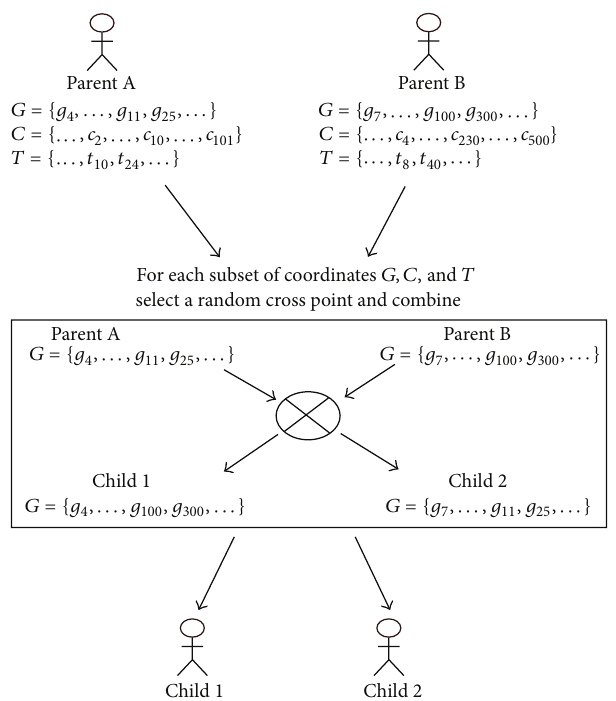
Figure 6: Representation of the crossover